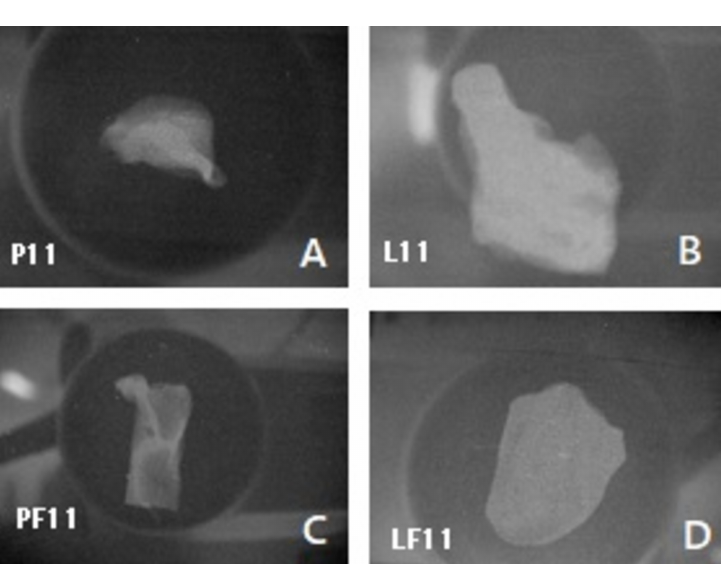
Fig. 6 - Mammography radiologic studies. A) Control bovine pericardium group (P); B) study bovine pericardium group (PF); C) control porcine aortic leaflets group (L); D) study porcine aortic leaflets group (LF).